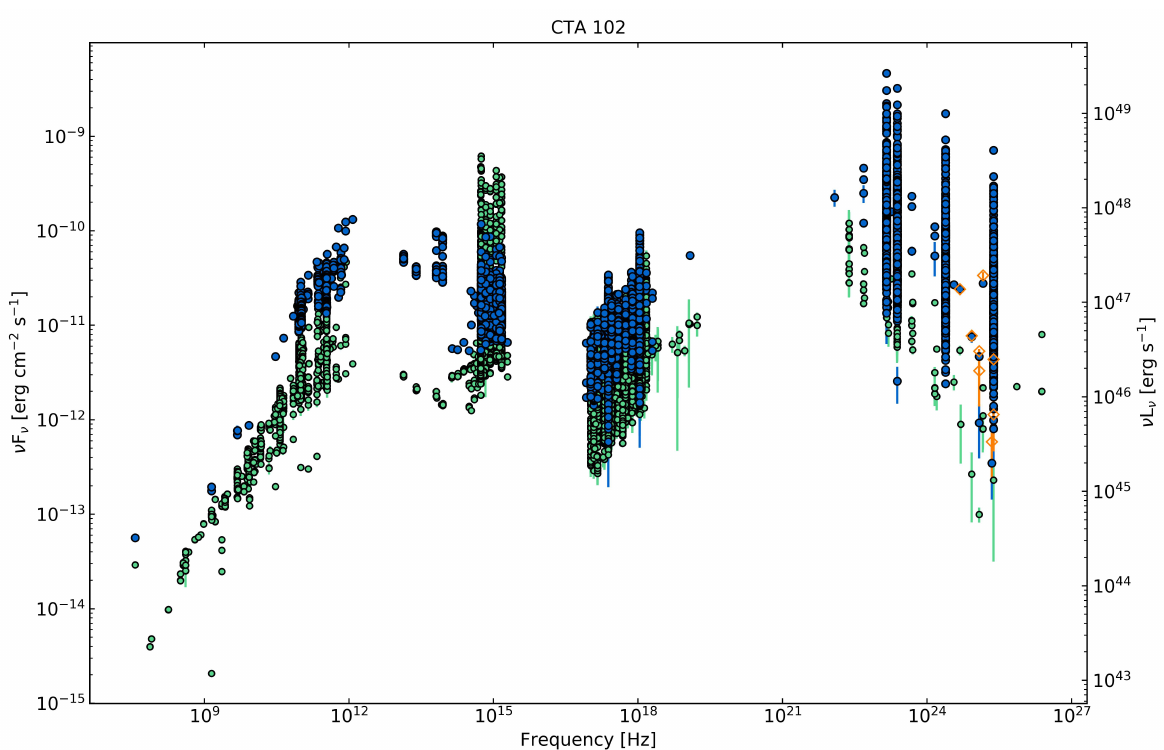
Figure 4. Radio to gamma-ray Spectral Energy Distribution of the blazar CTA102, one of the most luminous sources in the sky. Note the very large variability present at far-infrared, optical, X-ray and γ -ray frequencies.